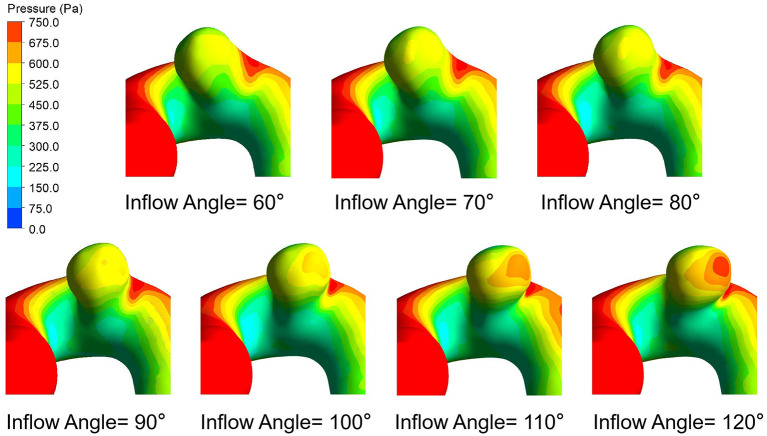
Pressure distributions of seven IA models with different inflow angles at peak systole.